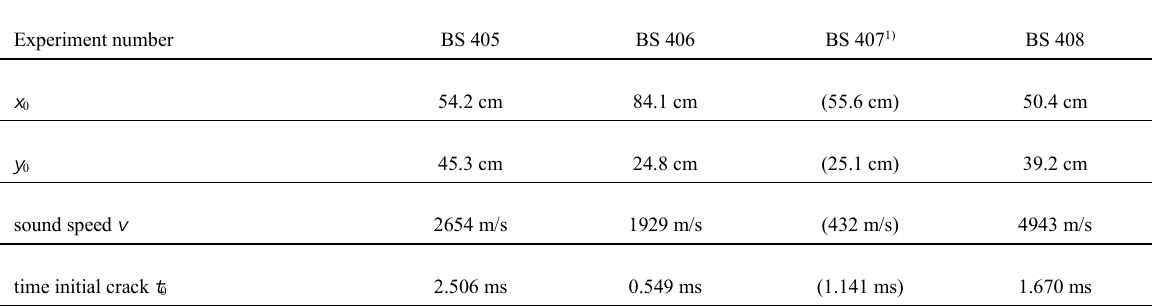
Table 5: Summary of location and time of the initial crack and sound speed (BS405 to BS408) determined by acoustic emission testing. Point of origin is the lower left corner of the glass pane.